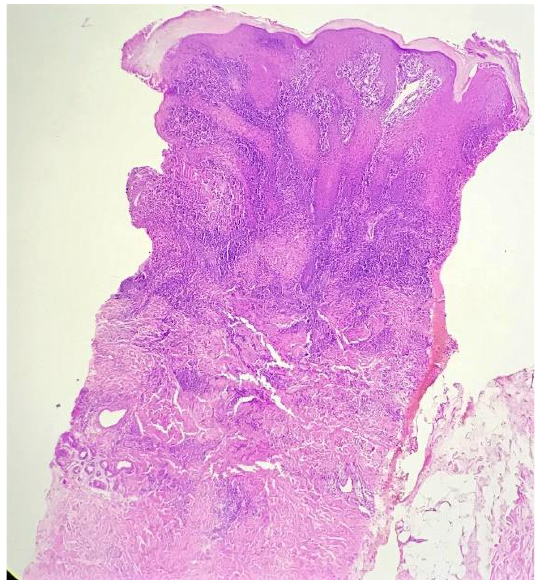
Figure 2. Lichenoid granulomatous dermatitis pattern with psoriasiform epidermal hyperplasia (H&E ×